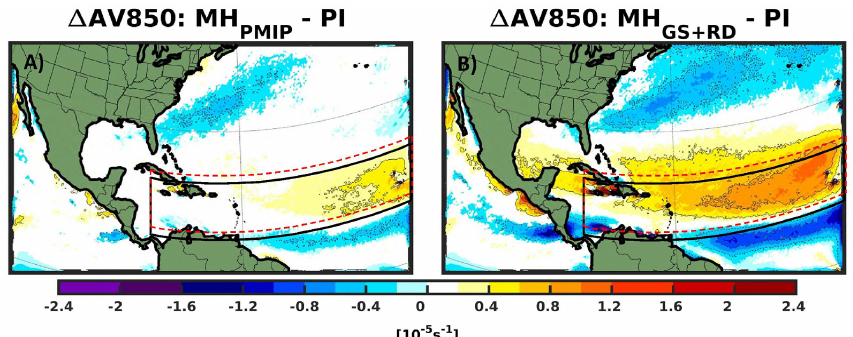
Figure A5. Climatological (JJASON) changes in 850hPa absolute vorticity relative to PI for the (a) MH PMIP experiment and (b) MH GS + RD experiment. The black box represents the approximate present-day MDR. The dotted red box shows the approximate shift in the absolute vorticity maxima. Only values that are significantly different at the 5% level using a local (grid-point) t test are shaded. The contour lines follow the color-bar scale (dashed, negative anomalies; solid, positive anomalies); the 0 line is omitted for clarity.